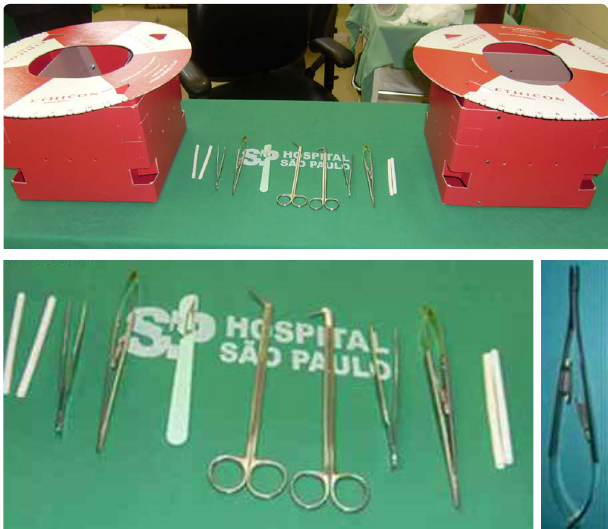
Fig. 1 - Arroyo box Simulator - Instrumental used for coronary anastomosis training. Featured port: Castroviejo